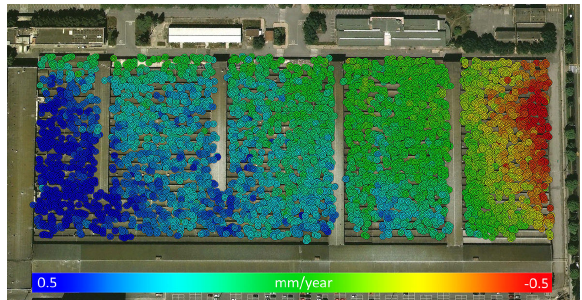
Figure 3. Deformation map of a warehouse estimated from 13 TerraSAR-X images with the standard PSI